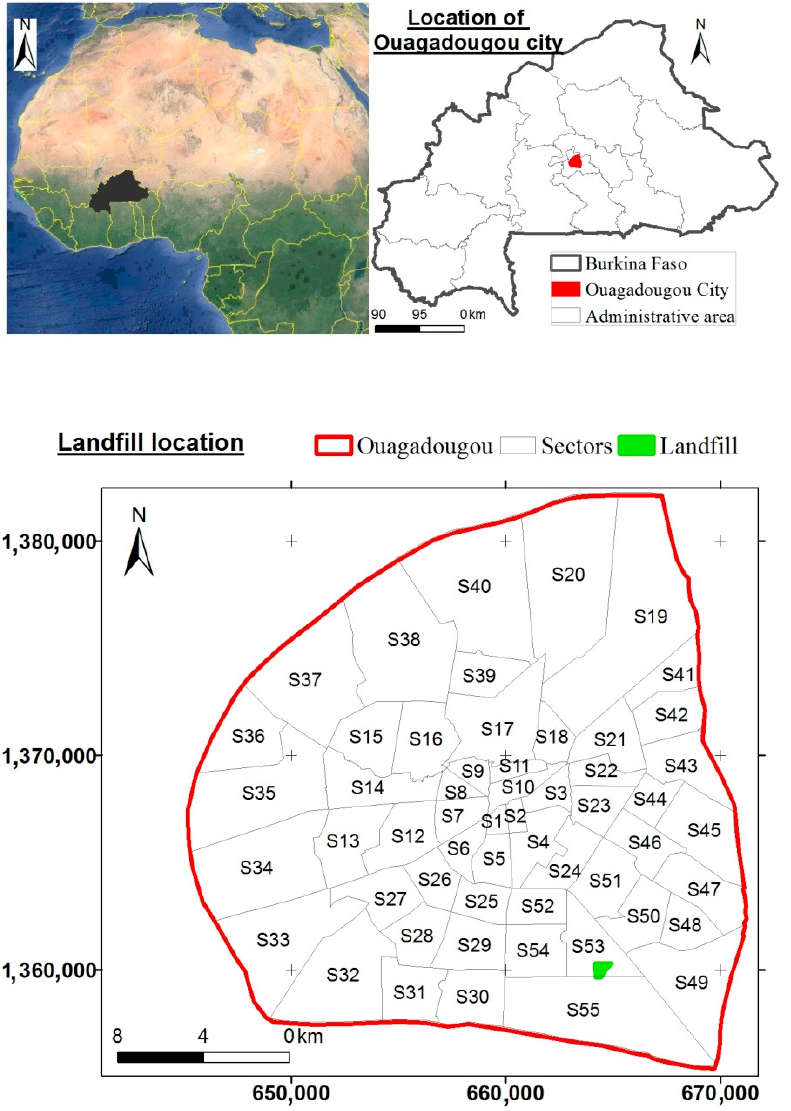
Figure 1. Location of the landfill on sector 53 of the Ouagadougou City, Burkina Faso (WGS84-UTM coordinates, zone 30N).